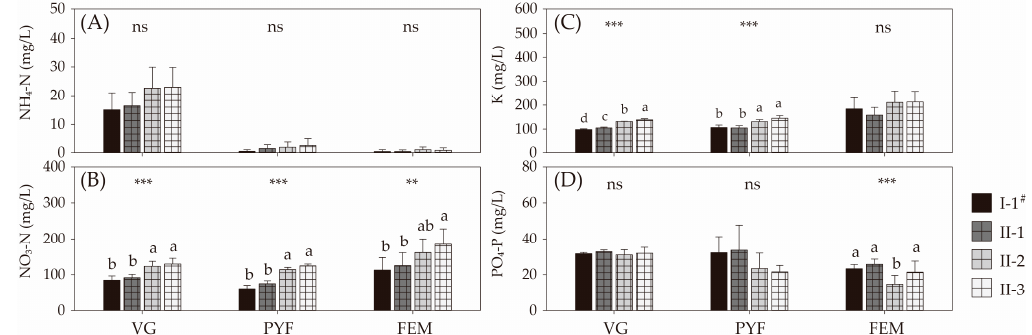
Figure 4. Mean ( + sd) of ( A ) NH 4 -N, ( B ) NO 3 -N, ( C ) K, and ( D ) PO 4 -P concentrations of the hydroponic solutions measured during VG, PYF, and FEM from the four different nutrient treatments in Experiment II. Bars of different colours represented different nutrient treatments. Statistical significances tested with one-way ANOVA were denoted by asterisk: p < 0.05 *, p < 0.01 **, p < 0.001 ***. Codes and details for the experimental treatments refer to Table 2.